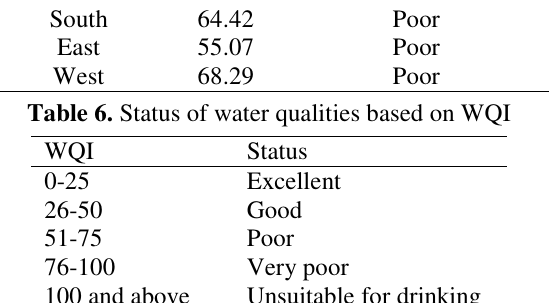
Table 5. Water Quality Index (WQI) of ground water of various regions of Gandhinargar taluka Various regions (According to Table 6)